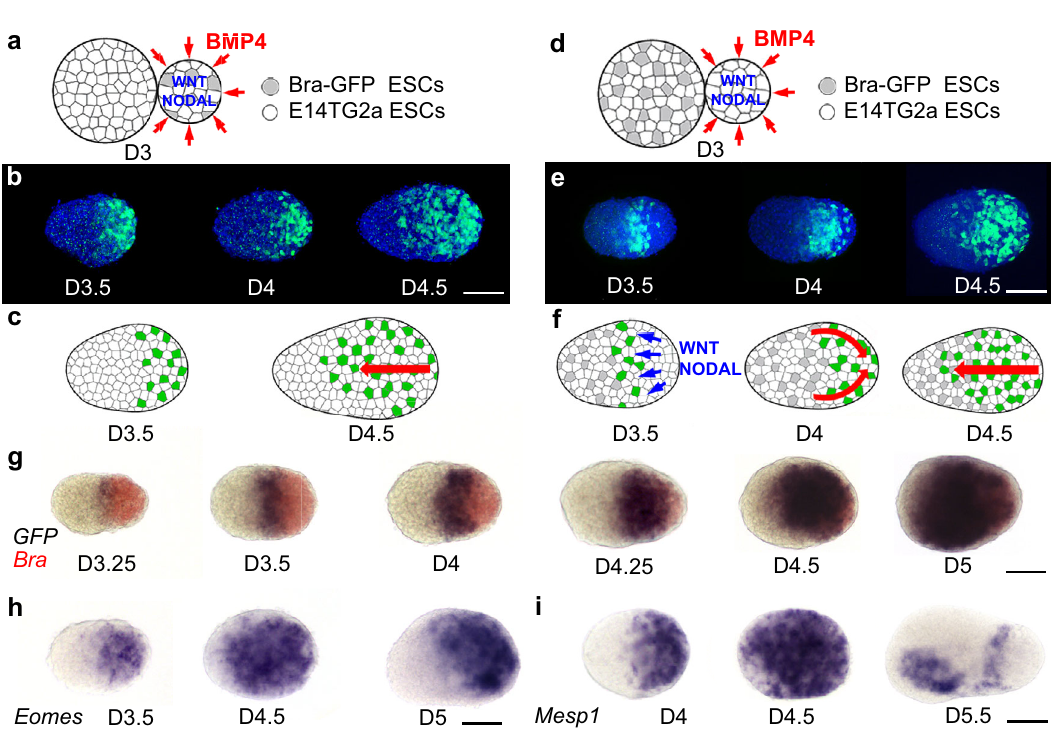
Fig. 2 Position over time of mesodermal cells during the gastrulation of embryoids. a – c Position over time of mesodermal cells induced in the signalling centre composed of 90% of unlabelled cells and 10% of Bra-GFP ESC. a Schematic of the experiment. b Visualization of Bra GFP expressing cells (green) and of cell nuclei (Hoechst — blue) in fi xed embryoids (D3.5 to D4.5). c Interpretive drawing: mesodermal cells induced by WNT3 and NODAL in the signalling centre were observed progressively more anteriorly during gastrulation (red arrow). d – f Position over time of mesodermal cells induced in the naive aggregate made of 90% unlabelled cells and 10% Bra-GFP ESC by WNT3 and NODAL secreted by the signalling centre. d Schematic of the experiment. e Visualization of Bra GFP (green) and of cell nuclei (Hoechst — blue) in fi xed embryoids from D3.5 to D4.5. f Interpretive drawing (red arrow: change in position of Bra GFP ). WNT3 and NODAL secreted by unlabelled cells of the signalling centre induced expression of the Bra GFP in a stripe of adjacent